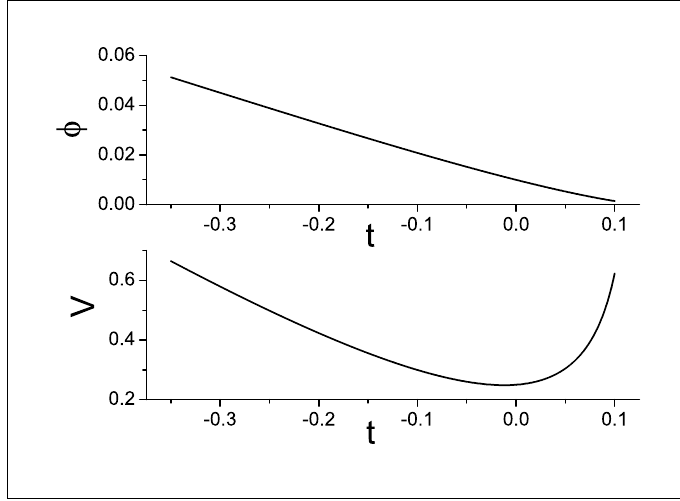
Figure 2. Solution for scalar field φ ( t ) ( upper graph ) and of potential V ( t ) ( lower graph ), for the holonomic basis, under imposed bouncing scale factor Equation (24) with B (cid:3) 1 , in units where 8 π G (cid:3) 1 .